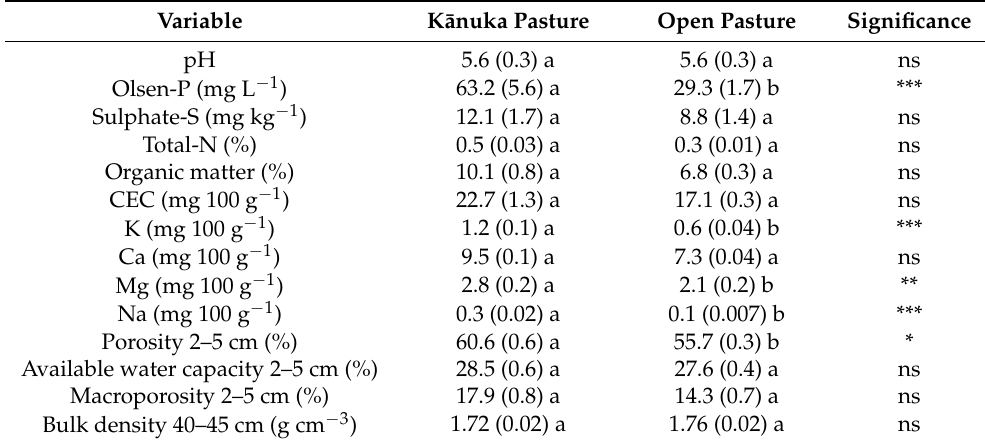
Table 3. Soil variable measurements for the treatments averaged between sites. The standard error of the mean is given in brackets.